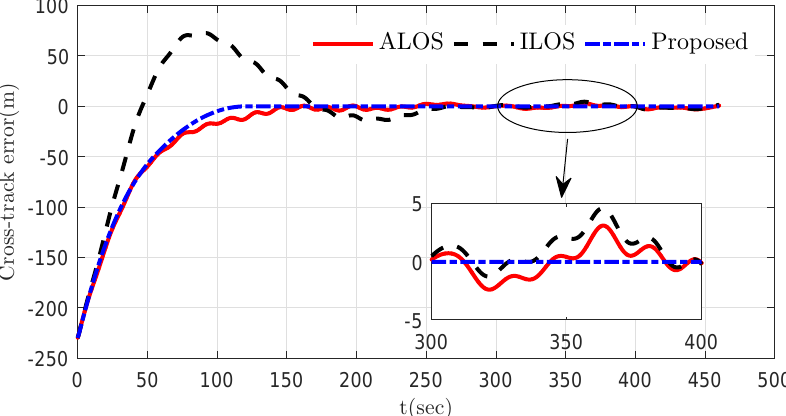
Figure 4. Cross-track error comparisons of proposed method, ALOS and ILOS-based